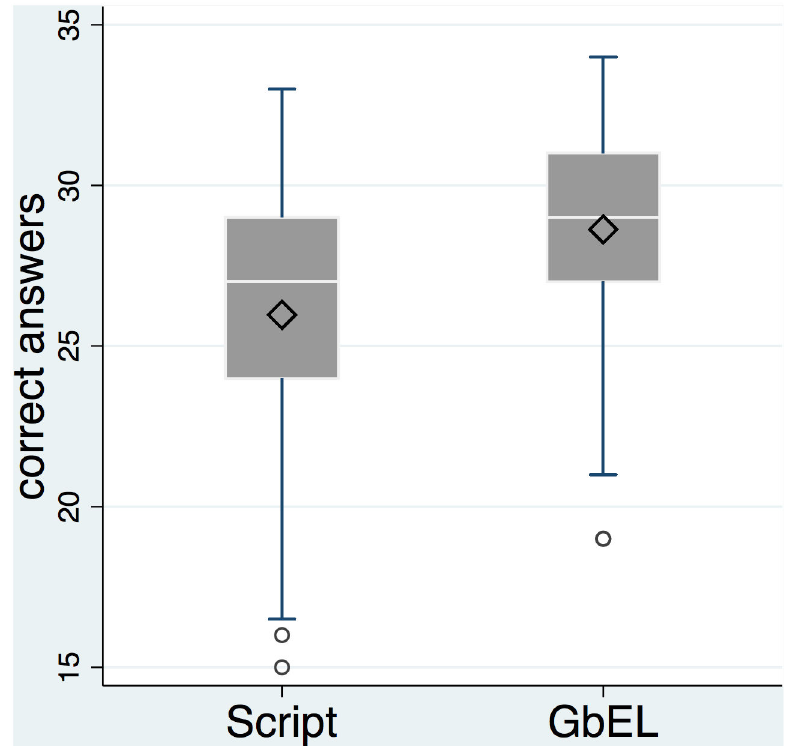
Figure 4. ITT analysis: distribution of the data in the script group and the GbEL group. doi: